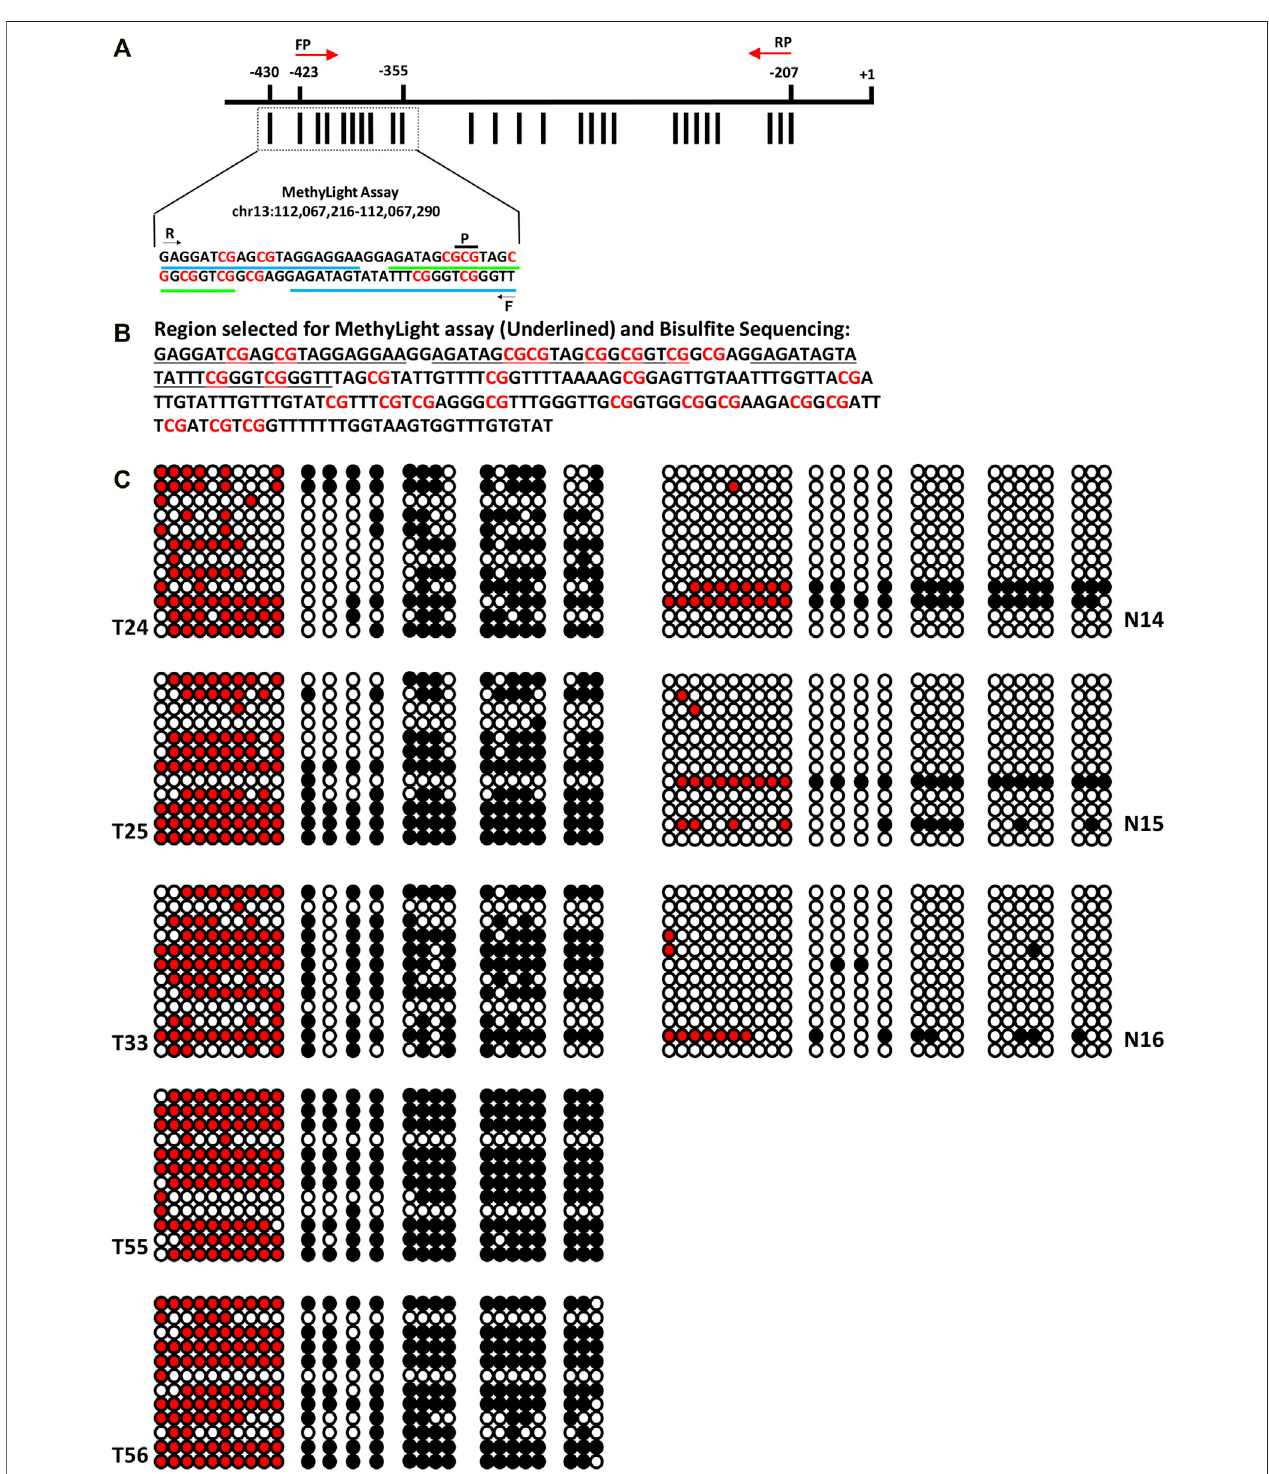
FIGURE 4 | Clonal Bisul fi te sequencing of SOX1 in normal and EOC tissues. (A) Promoter region of SOX1 comprising 26 CpG sites. The distribution of CpG sites (verticalbar)andpositionofthehybridizedPCRprimers(F:forwardprimer,R:reverseprimer, p :probe)forMethyLightassayandforclonalBisul fi tesequencing(indicated withredcolorarrow)areshown. (B) NucleotidesequenceofthepromoterregionofSOX1forMethyLightandbisul fi tesequencing. (C) Clonalbisul fi tesequencingresults for normal and malignant tissues samples of EOC. For each selected tissue sample, 12 randomly chosen clones were sequenced and the methylation status all 26CpG sites is indicated by the circles: closed (black) and open circles represent methylated and unmethylated CpG sites, respectively. Closed (red) represents methylated CpGs in the region analyzed by MethyLight assay.